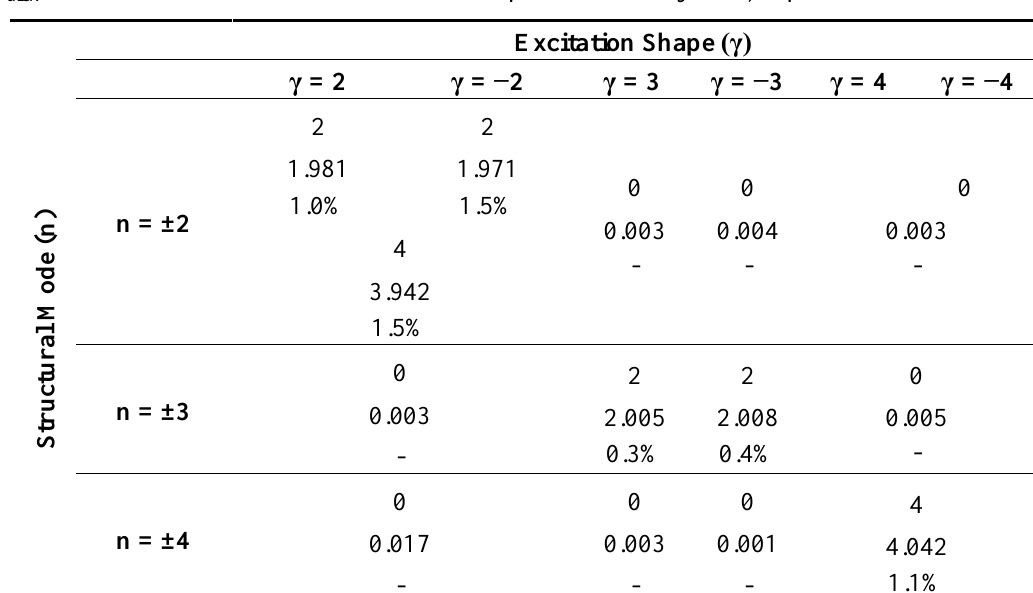
/A ) of the rotating disk in air γ 1-PATCH